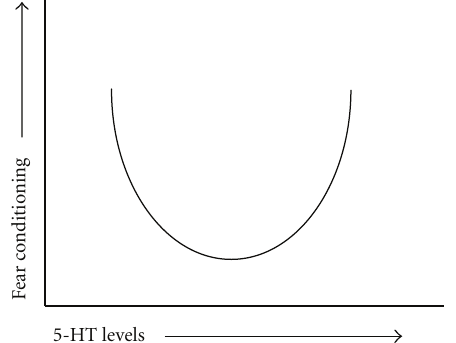
F3:SuggestedU-shapedrelationshipbetween5-HTlevelsand the extent of fear conditioning. Available studies suggest that both too high (e.g., 5-HTTLPR s-allele, 5-HTT knockout, MAO-L, acute SSRI) and too low (e.g., Lmx1b knockout, ATD, pCPA) 5-HT levels increaseassociativelearningandstrengthentheassociationbetween the CS and the